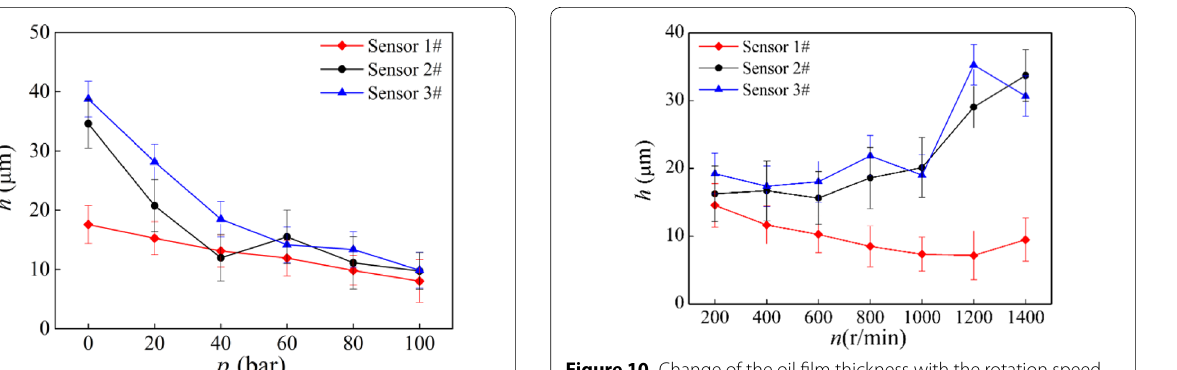
Figure 10 Change of the oil film thickness with the rotation speed at low pressure region